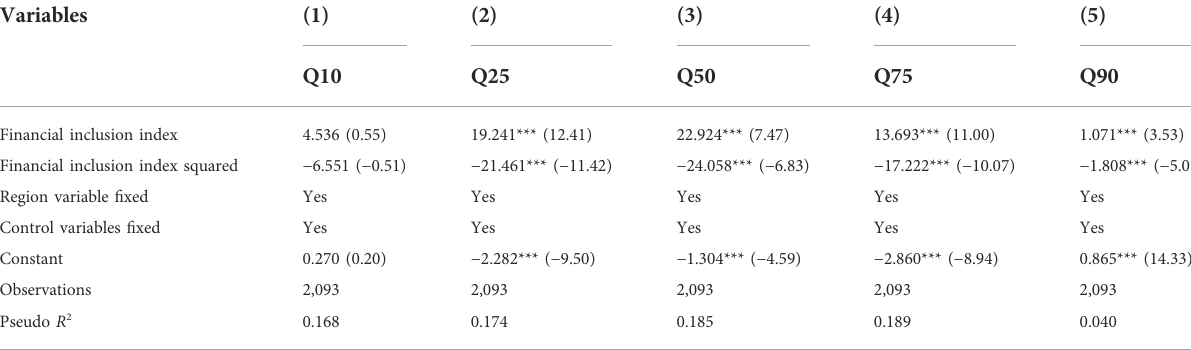
TABLE 4 IVQR results for the effects of fi nancial inclusion on economic vulnerability.